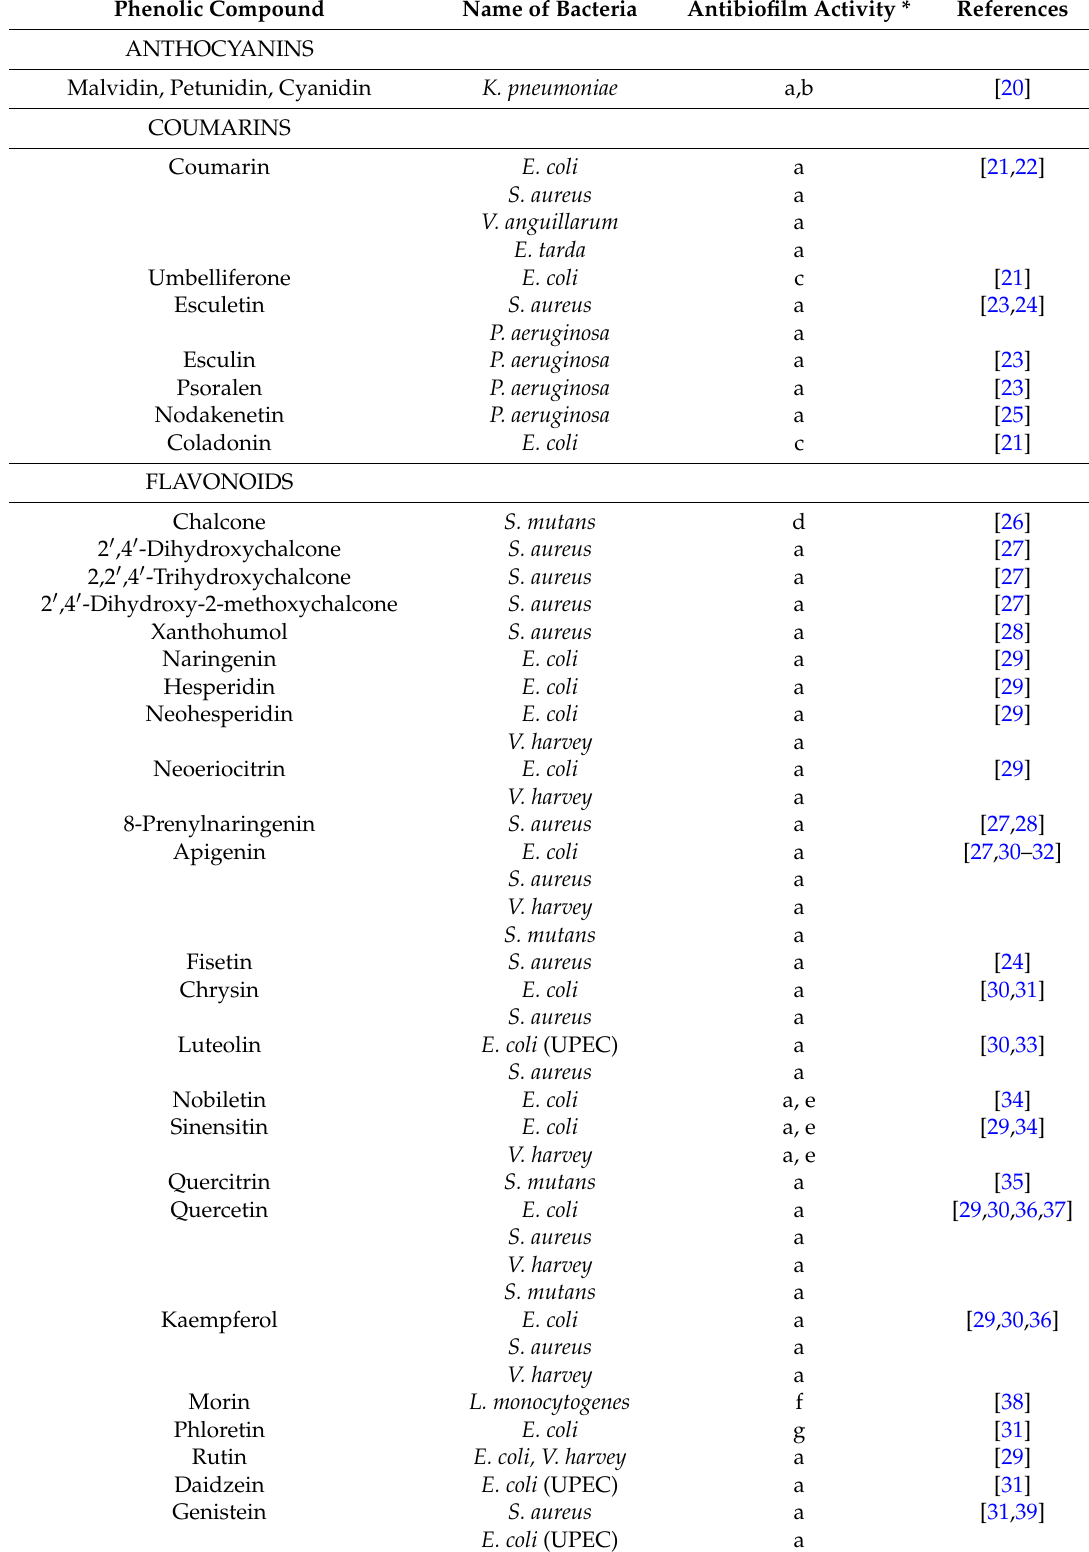
Table 1. Antibiofilm activities of flavonoids, phenolic acids and tannins contained in plant extracts. Phenolic